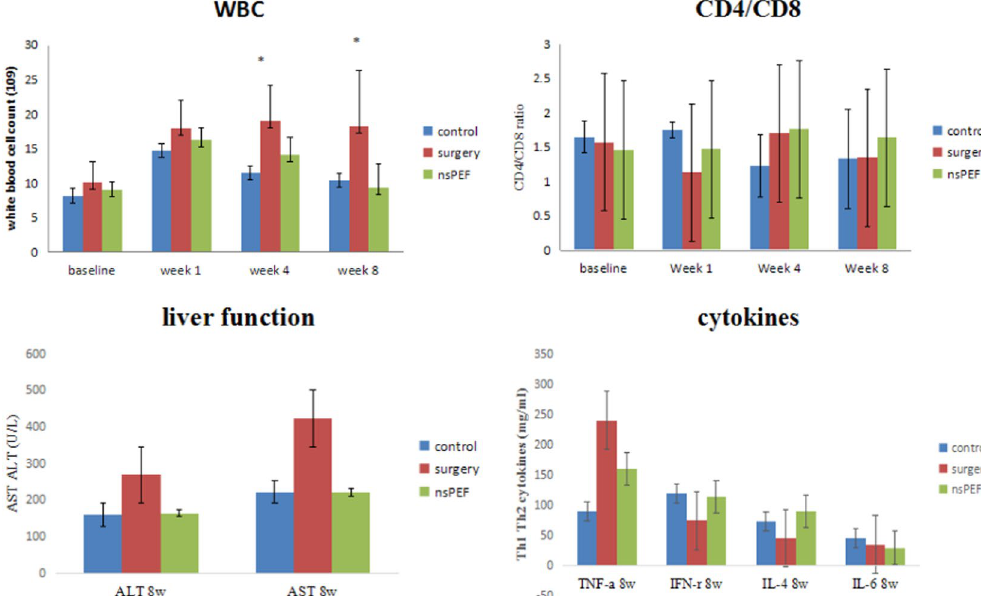
Figure 7. The laboratory follow -up of infection and liver function post nsPEF treatment. Mouse serum were collected at different time points after infection as indicated, Quantitative results of WBC before nsPEF, 1 week, 4 weeks and 8 weeks post nsPEF were shown * P < 0.05, between the indicated groups. Values were expressed as the mean ± SEM from 3 independent